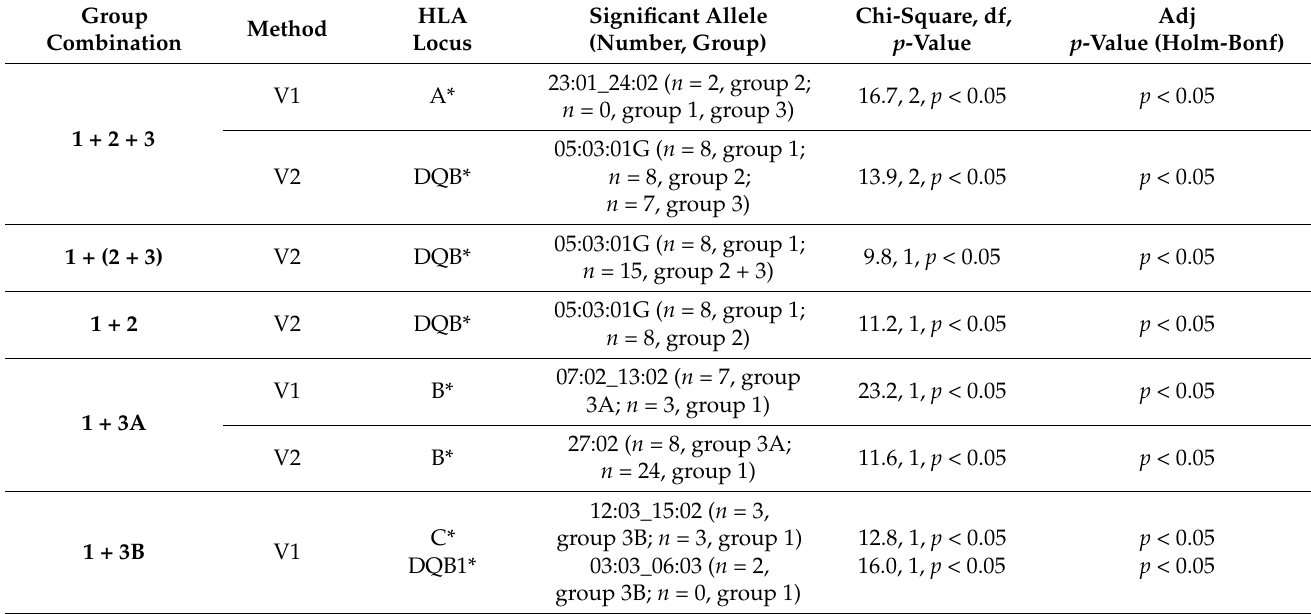
Table 7. Comparison of group combinations analyzed by V4